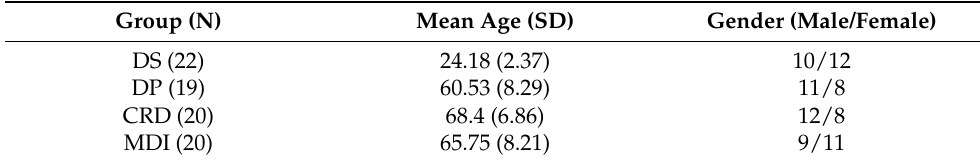
Table 1. (DS) dental students; (DP) dentate subjects; (CRD) complete removable denture max-